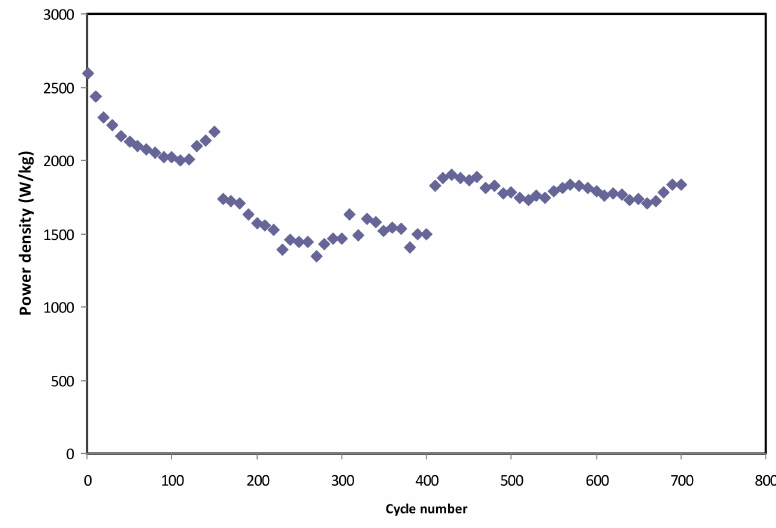
Figure 14. The power density of the fabricated EDLC for 100